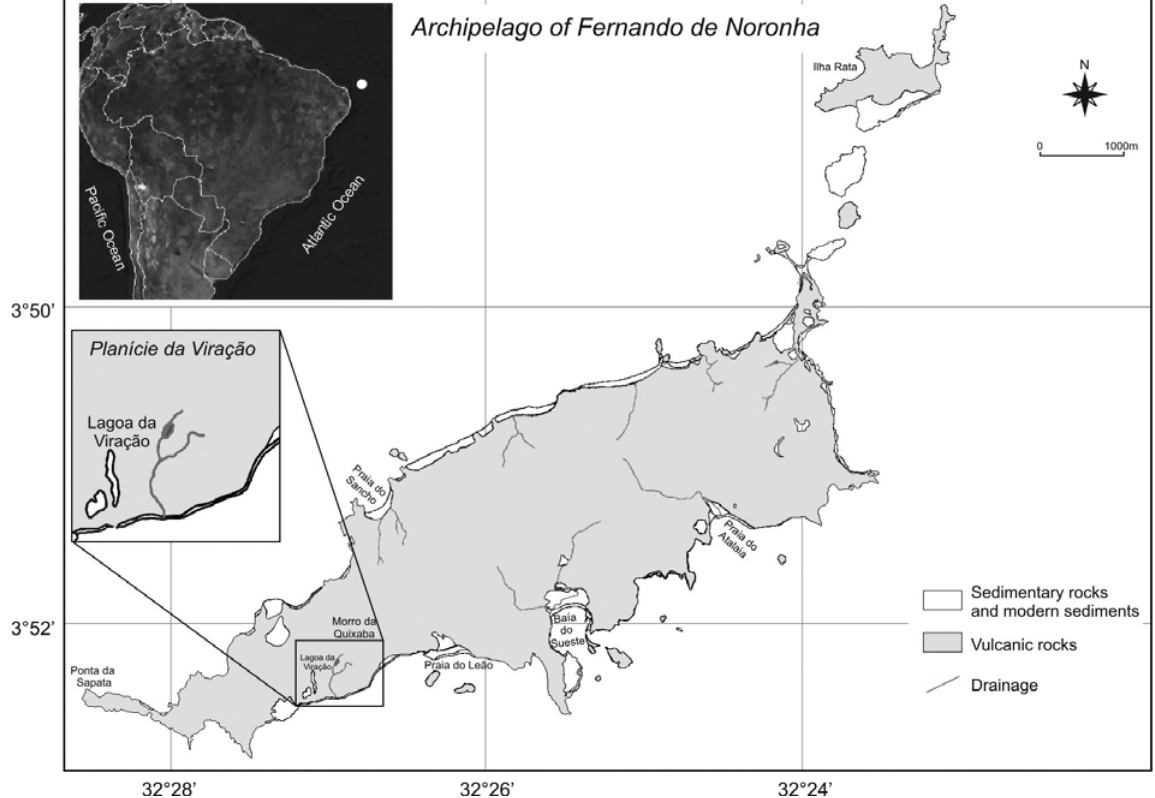
Fig. 1 – Archipelago of Fernando de Noronha showing the location of Lagoa da Viração (modified from Ulbrich et al. 2004). The Manguezal do Sueste is located in the Baía do Sueste. The geographic coordinates of soil sampling points are shown in the Table